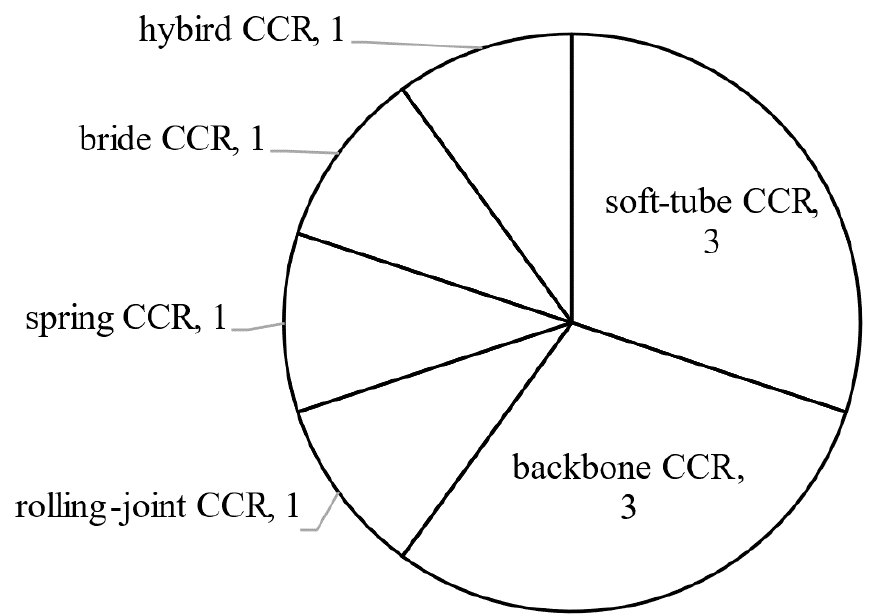
Figure 17. Numbers of publications about variable stiffness in different CCRs.